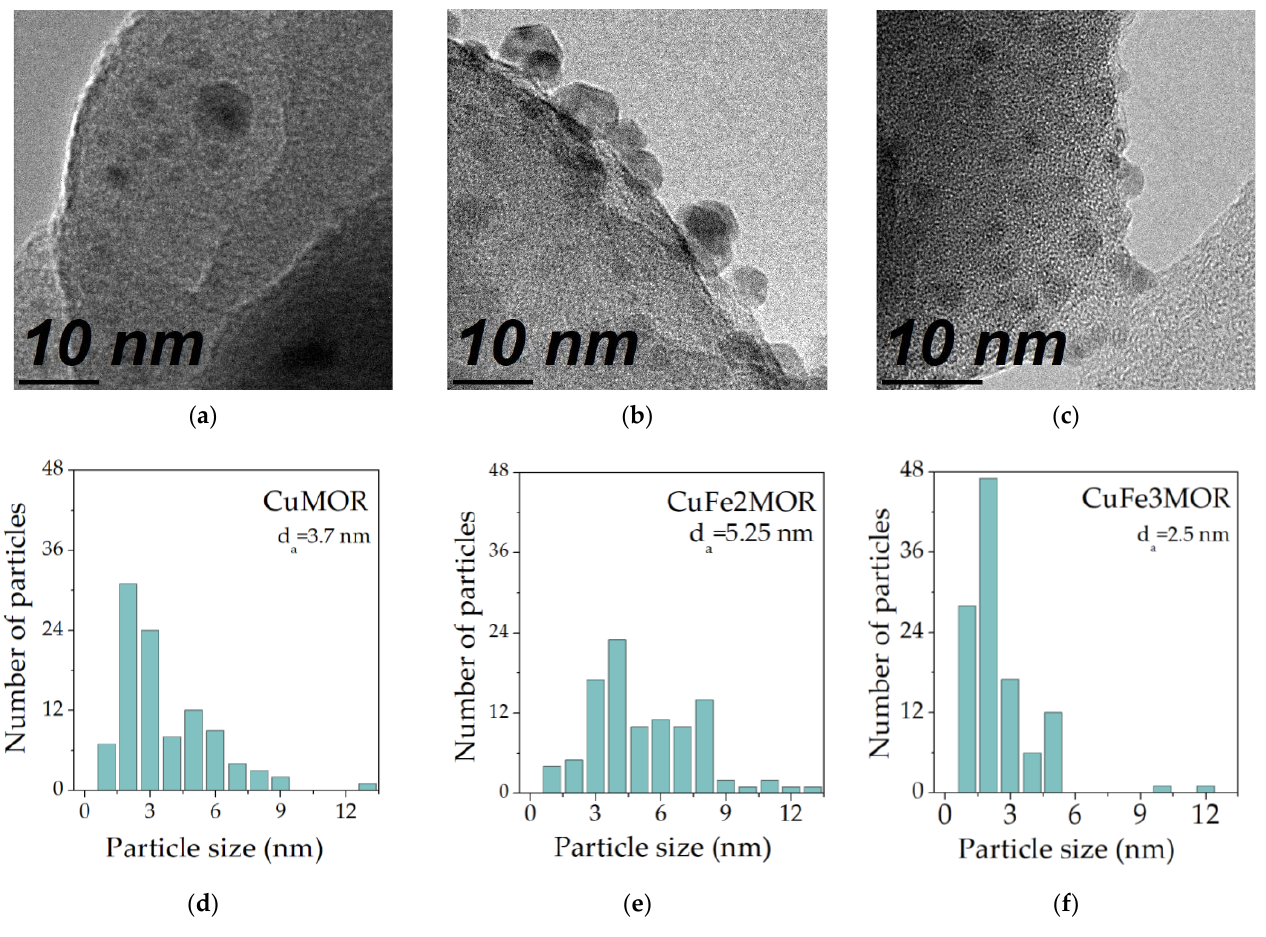
Figure 2. HRTEM images and particle size distribution of studied samples. Table 3. Textural properties of studied